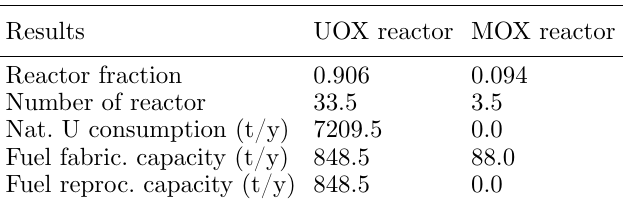
Table 4. COSI6/SEPAR comparison of fresh MOX